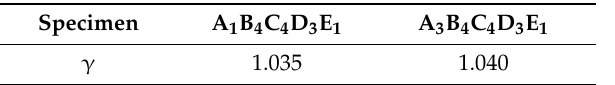
Figure 13. The influence of various factors on γ under different applied stresses: ( a ) 100 MPa, ( b ) 310 MPa. Table 8. The γ of selected specimens (100 MPa).